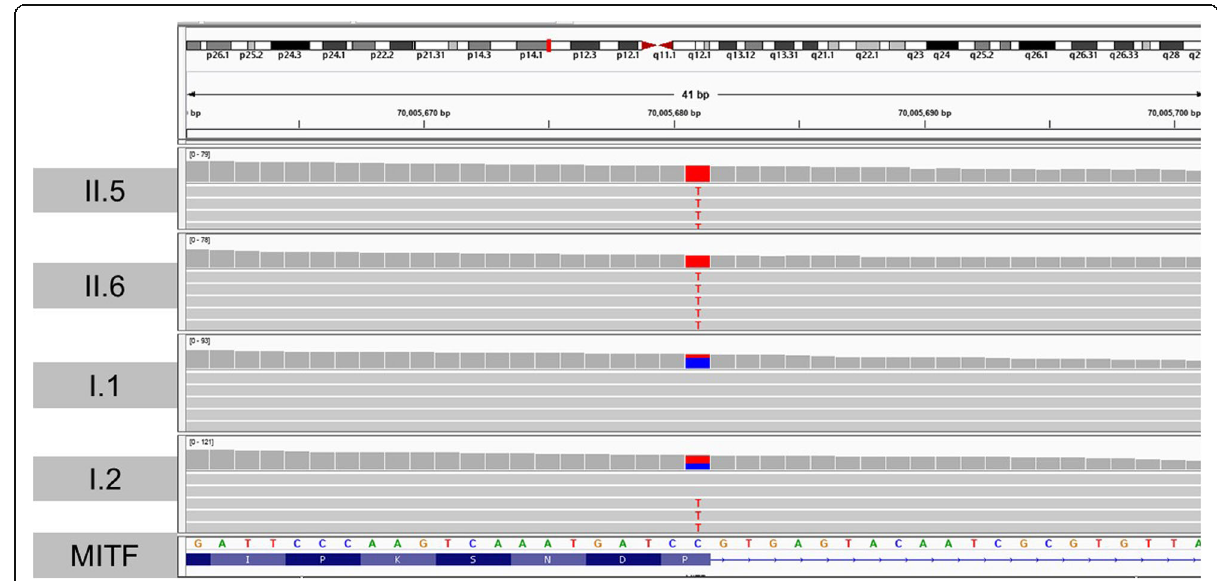
Fig. 3 Chromosomal localization of the MITF missense mutation. The NM_198159.2:c.1013C> T variant on chromosome 3 is visualized Using the IGV software. Both parents (I.1 and I.2) carry the heterozygous form (blue and red), whereas both affected daughters carry the homozygous form (red). The amino acids are shown in the lower panel below their corresponding codons, whereas a straight blue line was shown under the nucleotides that correspond to the intronic region